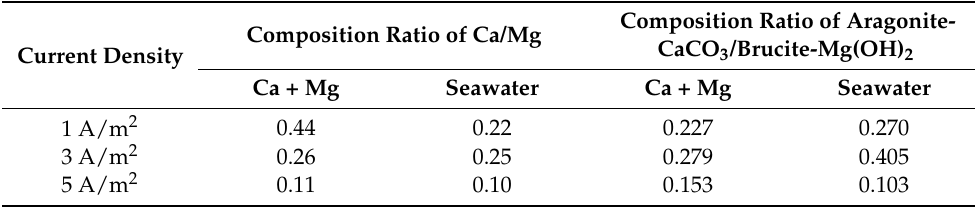
Table 4. Composition ratio (Ca/Mg) analysis of calcareous deposit films after 24 h.